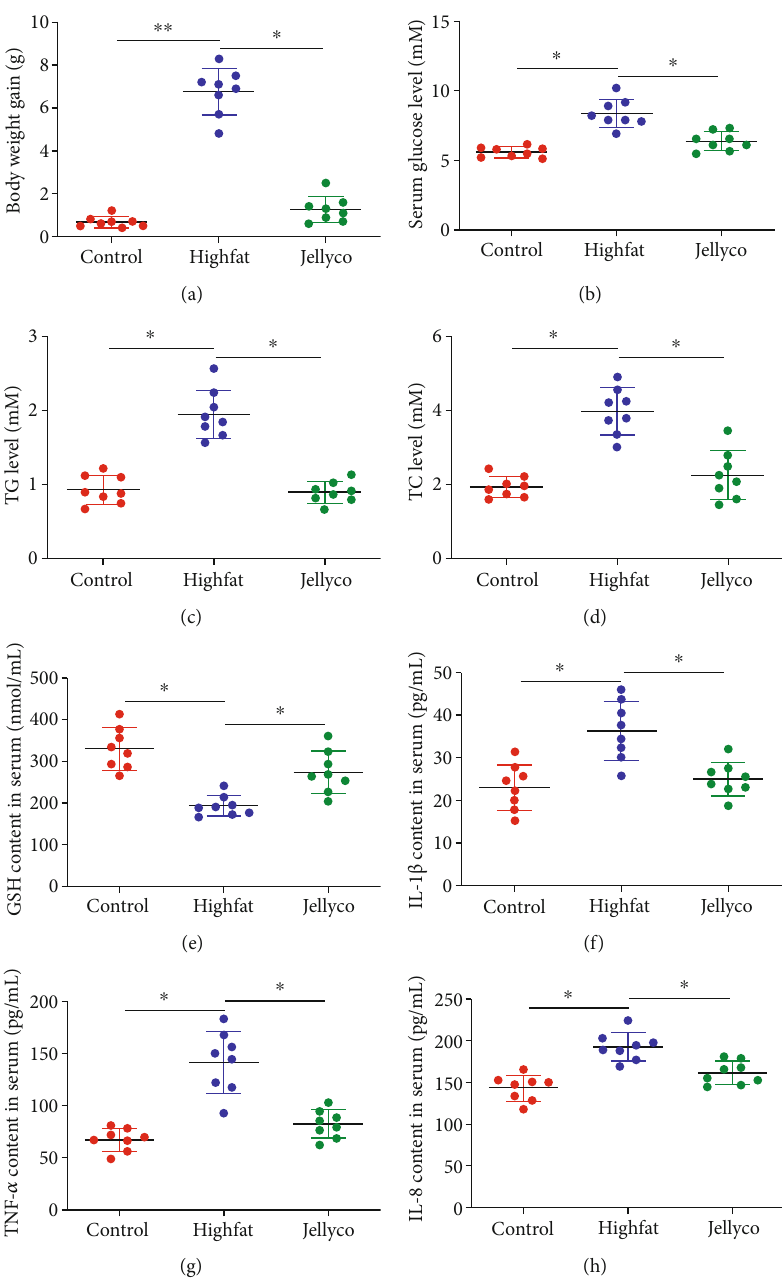
Figure 1: Jelly fi sh collagen hydrolysate decreased body weight gain and improved serum biochemical indicators and in fl ammatory cytokine concentration in high-fat diet-fed mice: (a) body weight gain, (b) glucose level, (c) TG level, (d) TC level, (e) GSH content, (f) IL-1 β content, (g) TNF- α content, and (h) IL-8 content. Data are expressed as means ± SEM , n = 8 . ∗ P < 0 : 05 , ∗∗ P < 0 : 01